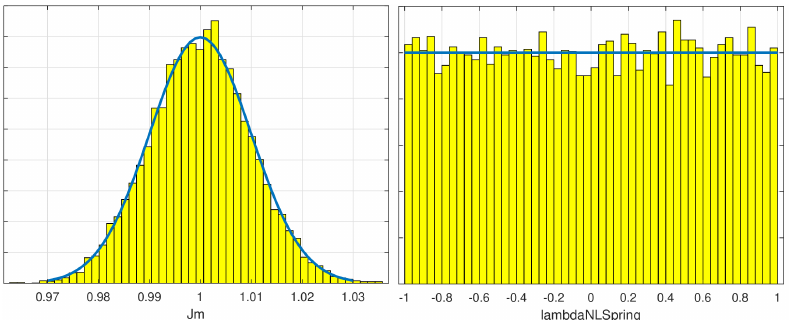
Figure 11. Frequency histogram for the normal distribution of parameter Jm (in kgm 2 ) and uniform distribution for lambdaNLSpring (dimensionless; lambdaNLSpring = 0) is the nominal value). The blue line shows the ideal probability density function and the yellow bars the sampled values.